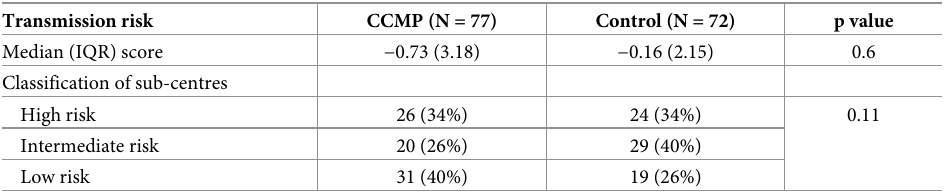
intervention–response gradient in this indicator. Table 3. Distribution of risk-stratified sub-centres across CCMP intervention and